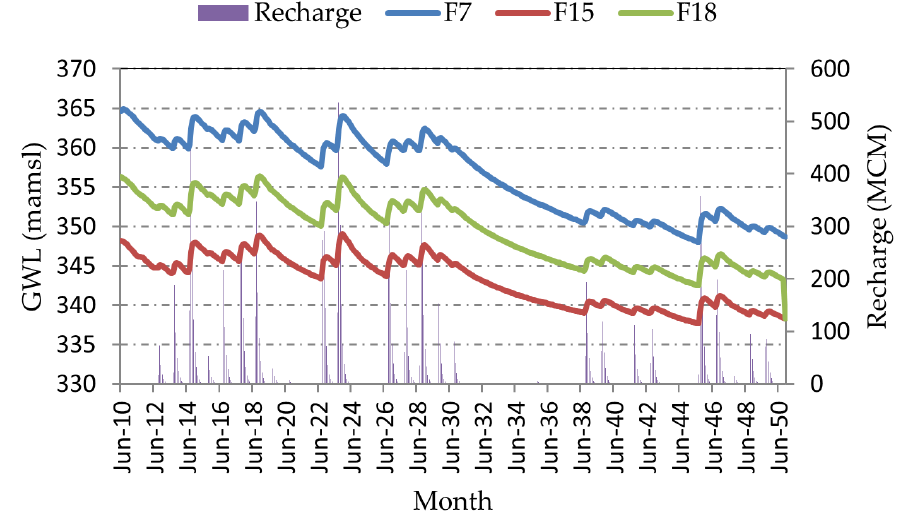
Figure 13. Long-term groundwater recharge in million cubic meters (MCM) calculated using historical and future climate data from the RCP4.5 scenario based on the Thornthwaite Monthly Water Balance and rainfall (mm) from 1970 to 2050.